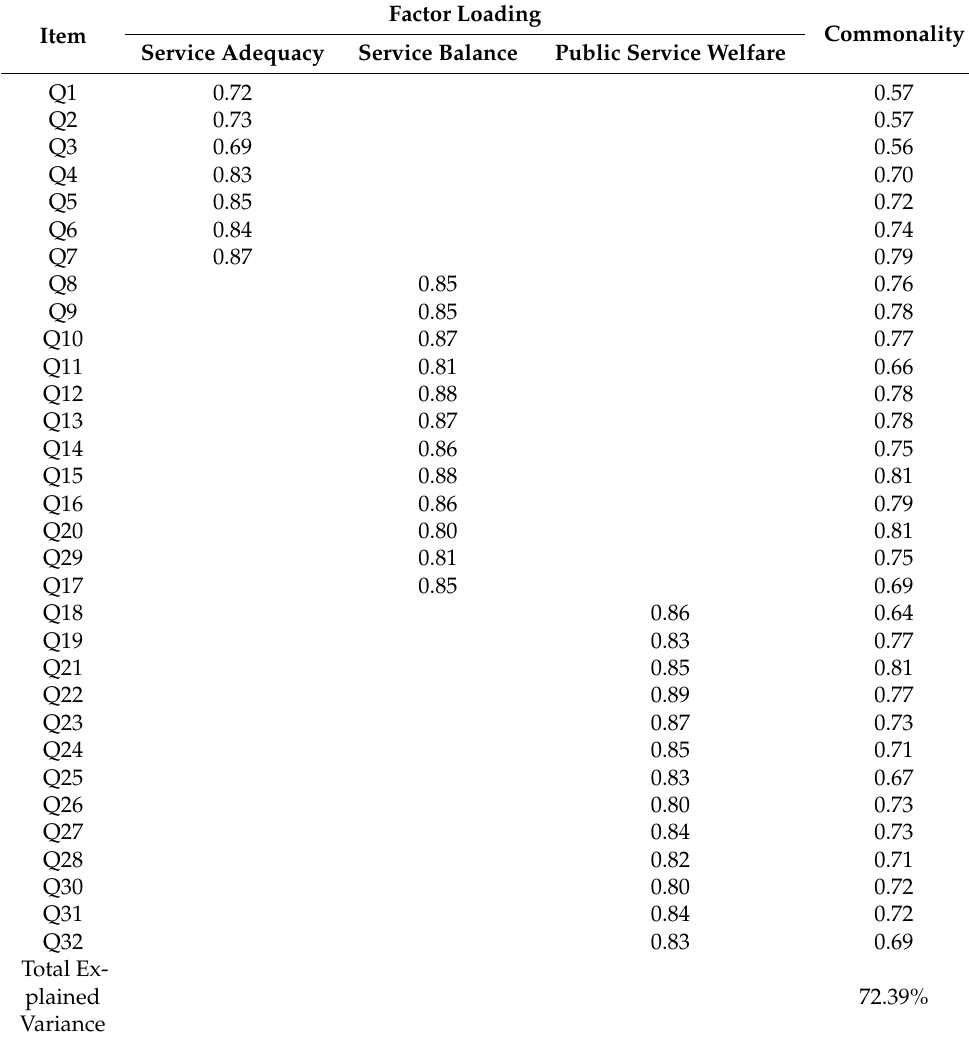
Table 2. Exploratory factor analysis